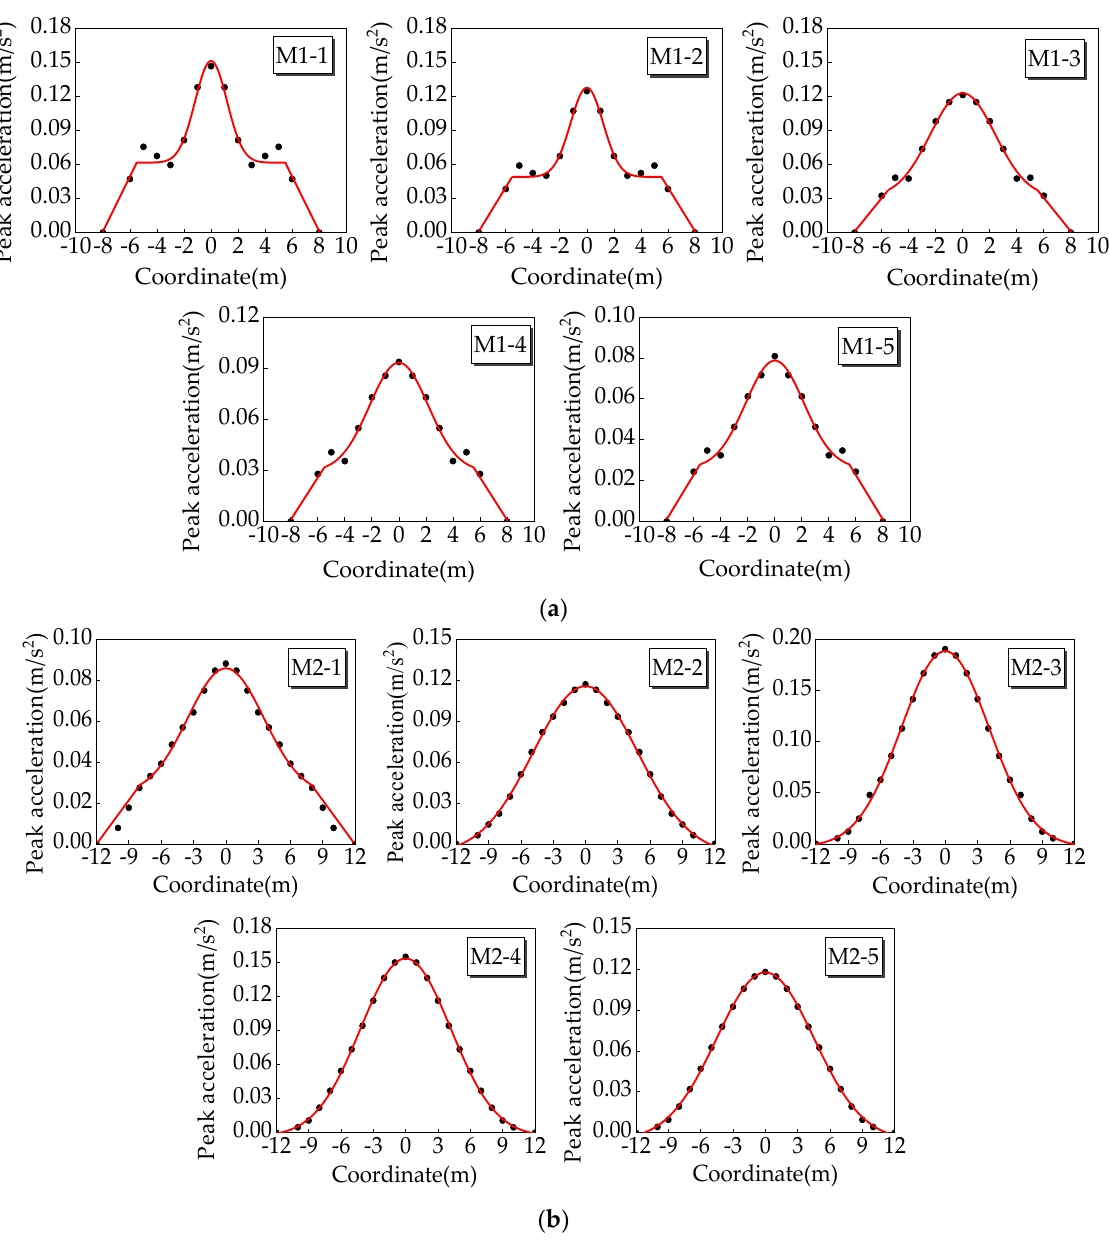
Figure 16. Nonlinear fitting curves: ( a ) model M1; ( b ) model M2.